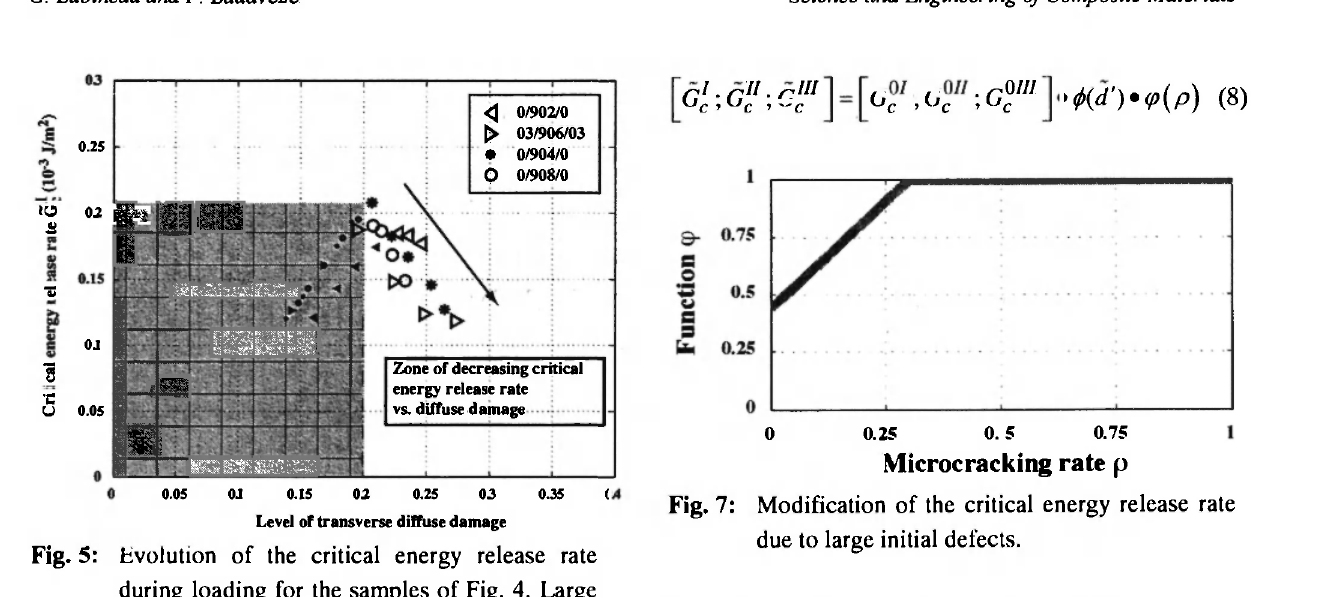
Fig. 5: Evolution of the critical energy release rate during loading for the samples of Fig. 4. Large symbols correspond to an associated value of ρ greater than 0.3, and small symbols to an associated value of ρ less than 0.3.